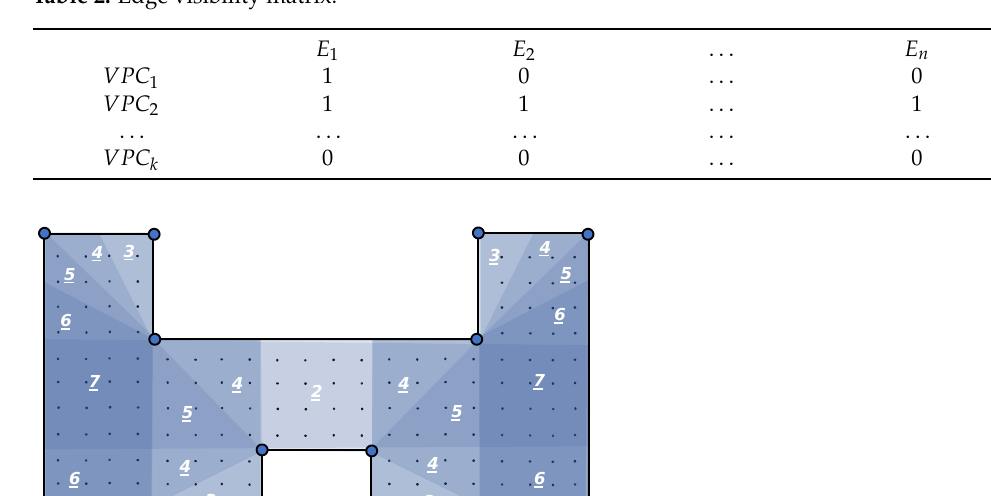
Table 2. Edge visibility matrix.